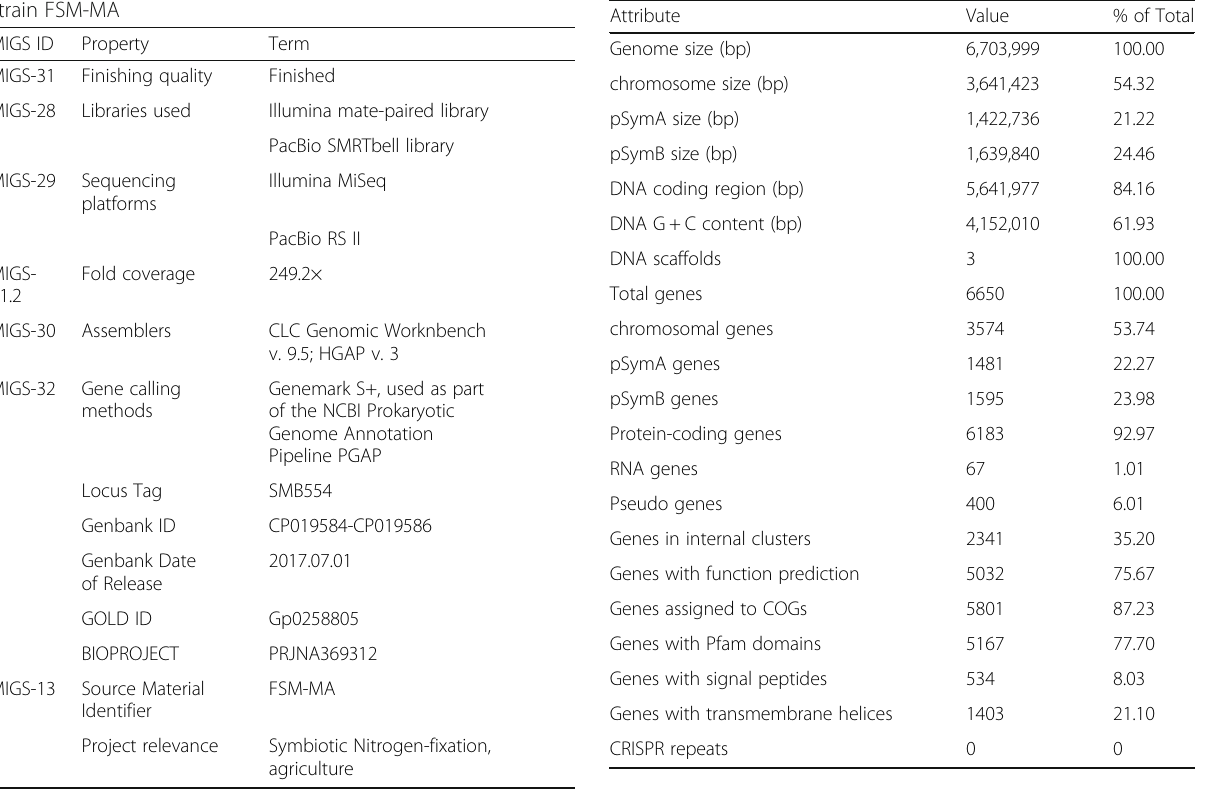
Table 2 Genome sequencing project information for E. meliloti